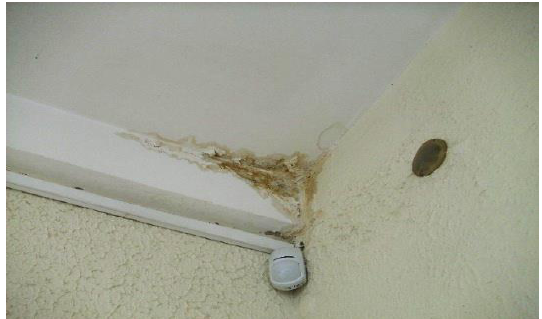
Fig. 2. Mushroom and mold on the building wall (own